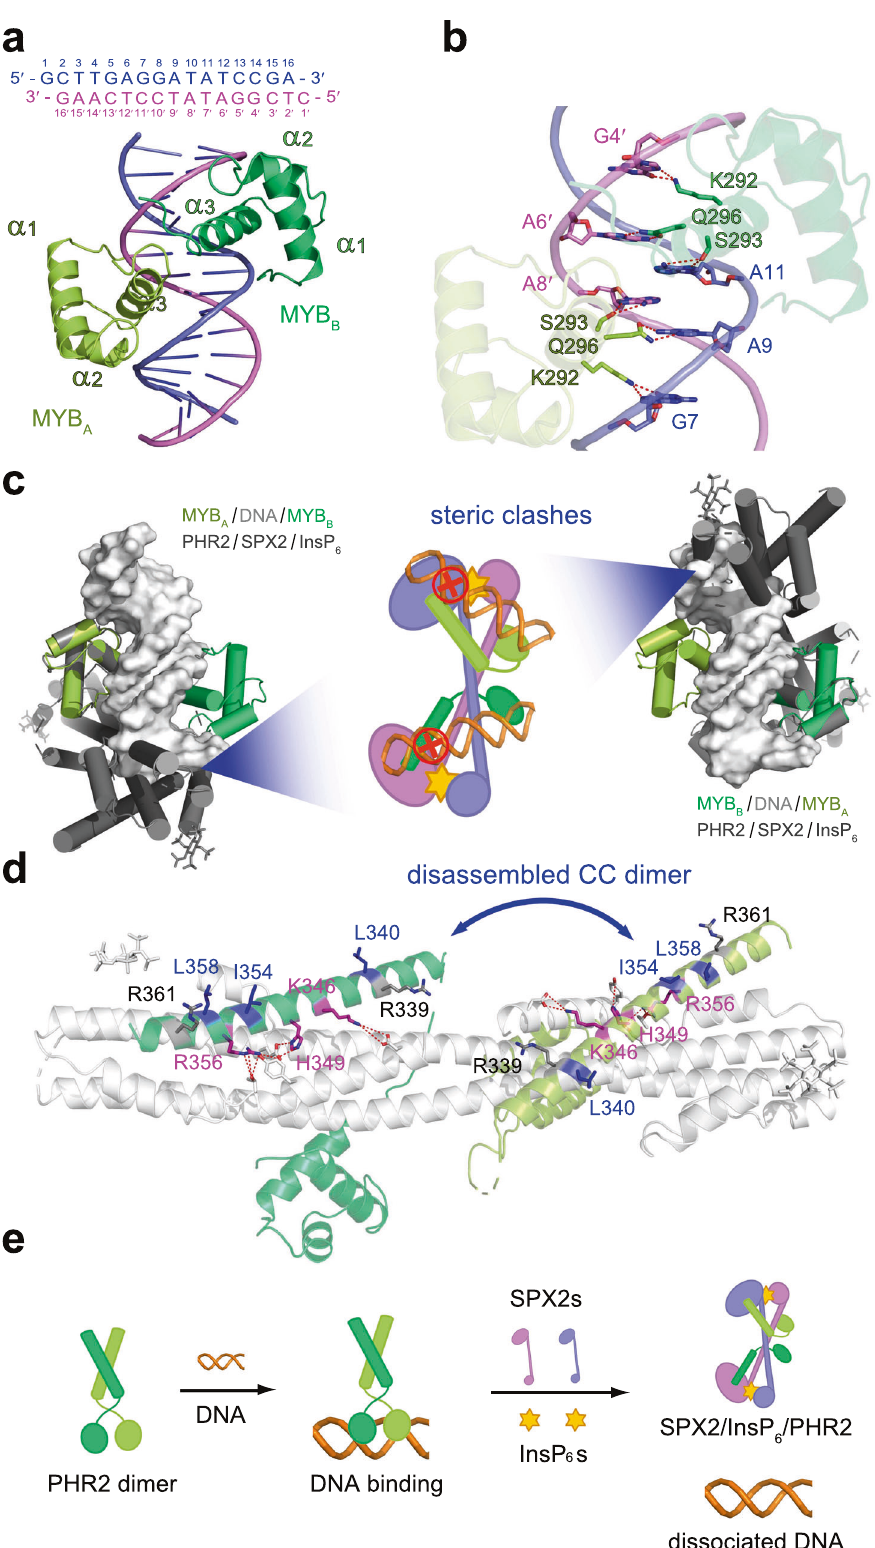
do not contribute to the formation of the signalling complex (Fig. 3a, c and Fig. 4d). We have previously reported that the residues L319, I333 and L337 in AtPHR1 stabilize the CC oligomer required for DNA/ promoter binding 26 . Our complex structure now uncovers the mechanism by which rice SPX2 disassembles PHR2 CC